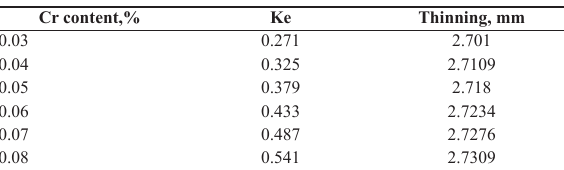
Table 4. Combinations of Cr content and Keller coefficient for feedwater pipelines.